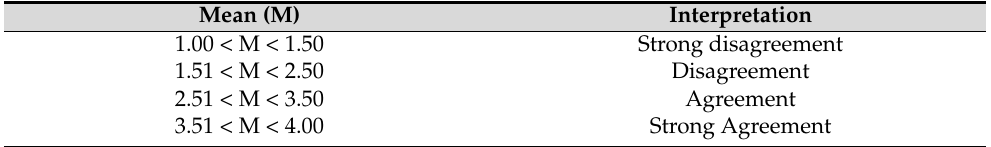
Table 1. Percentages for each proficiency